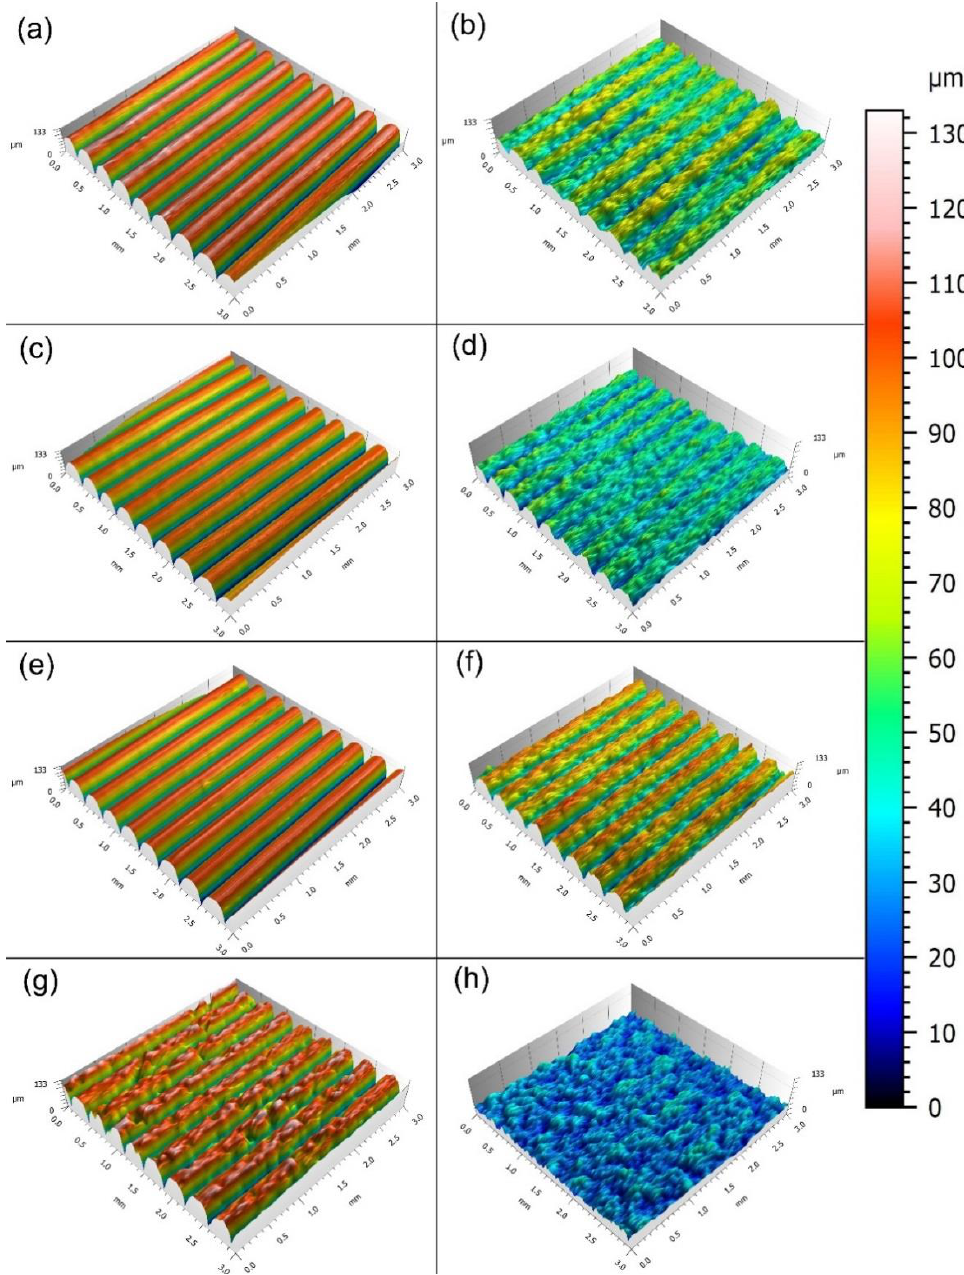
Figure 5. Reconstructed 3D surface topographies of the test blocks. ( a ) ABS before gritblasting (GB); ( b ) ABS after GB; ( c ) high impact polystyrene (HIPS) before GB; ( d ) HIPS after GB; ( e ) polyethylene terephthalate glycol copolyester (PETG) before GB; ( f ) PETG after GB; ( g ) Reference resin before GB; ( h ) Reference resin after GB.